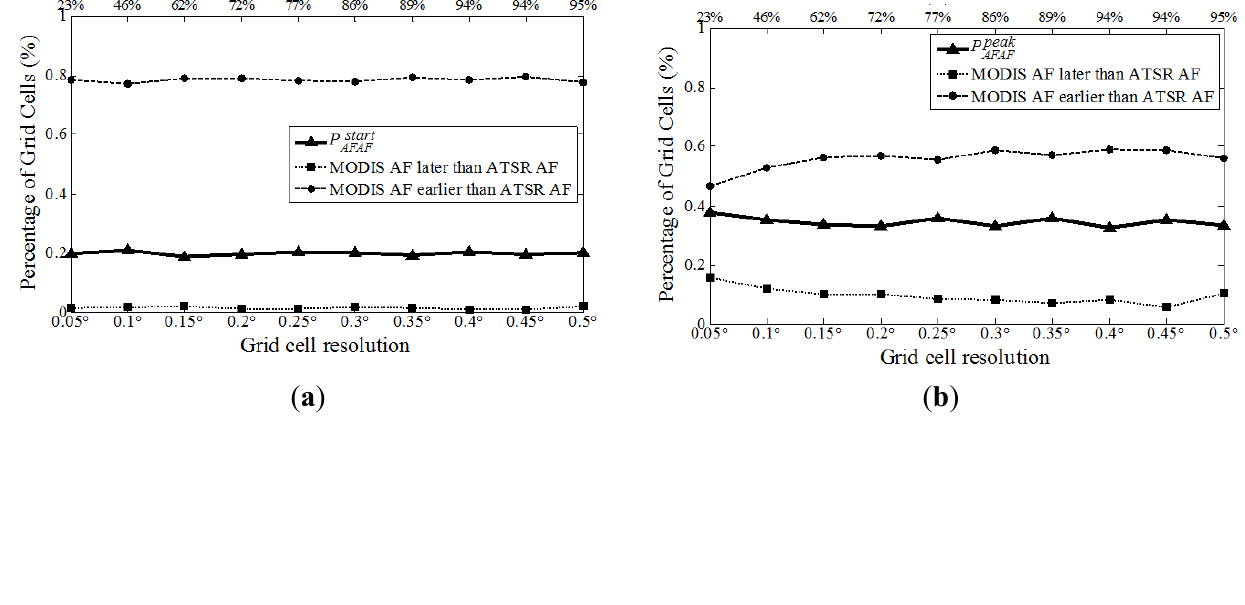
Figure 12. Comparisons of the ( a ) start; ( b ) peak; ( c ) end; and ( d ) duration of the fire season in the Central African Republic (CAR) derived from the MODIS and (A)ATSR active fire (AF) datasets at 16-day temporal resolution. For only the grid cells where both datasets recorded a fire pixel, the value of P (triangular symbols) indicates the proportion of grid cells that were assigned an identical start, peak, end or duration by both fire products. Where the fire products disagree, fire seasonality is characterized based on whether MODIS detected an earlier/later or a longer/shorter fire season than (A)ATSR. The proportion of grid cells in the CAR where comparisons were possible are labelled along the top